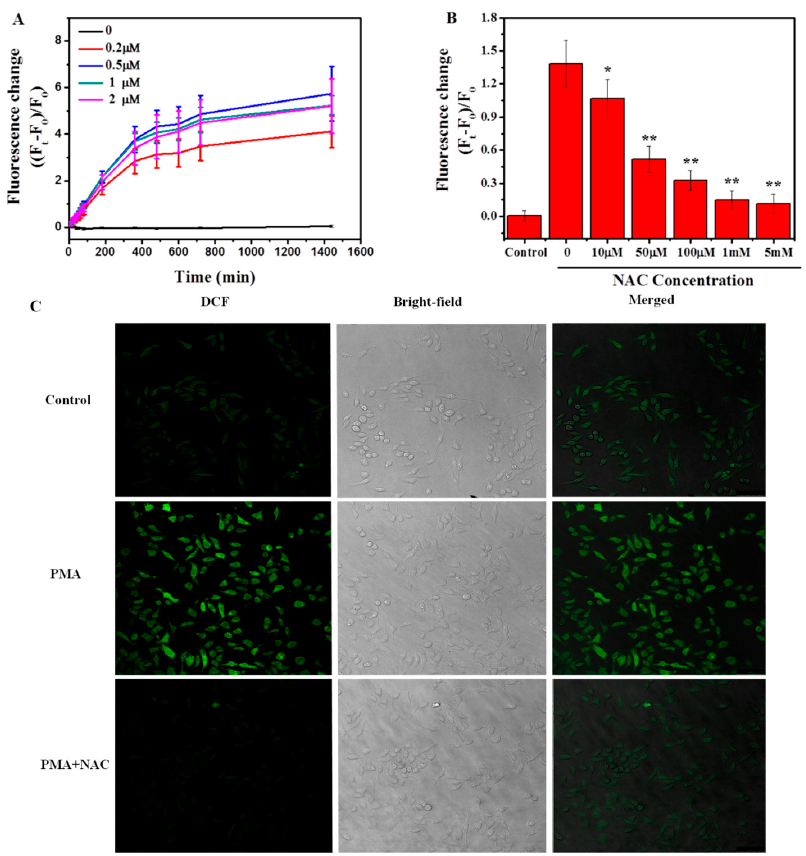
Figure 2. Induction and inhibition of respiratory burst in macrophages by PMA and NAC, respectively, evaluated through the generation of ROS. ( A ) Fluorescence intensity change of DCF over time in macrophages under the treatment of 0–2 μ M PMA; ( B ) Fluorescence intensity change of DCF in macrophages with different concentrations of NAC pretreatment, followed by 0.5 μ M PMA stimulation for 3 h (Ft); ( C ) Representative confocal images of macrophages treated in ( B ) with PMA concentration 0.5 μ M, and NAC 1 mM. Green fluorescence represents DCF signal. The control group was cells without any treatment. Scale bar = 50 μ M. (* p < 0.05; ** p < 0.01).